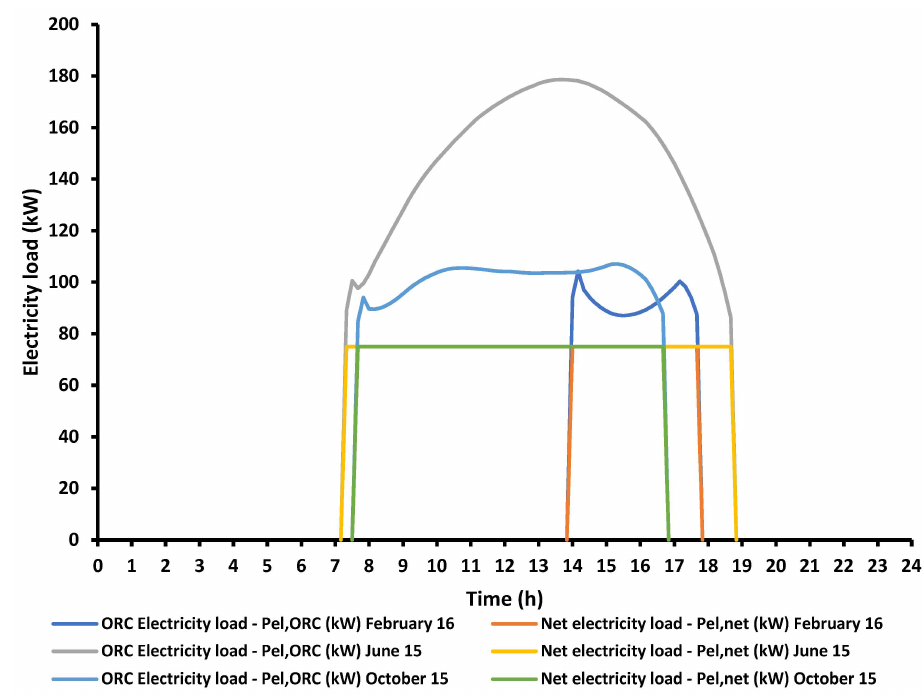
Figure 17. ORC and net electricity production during the